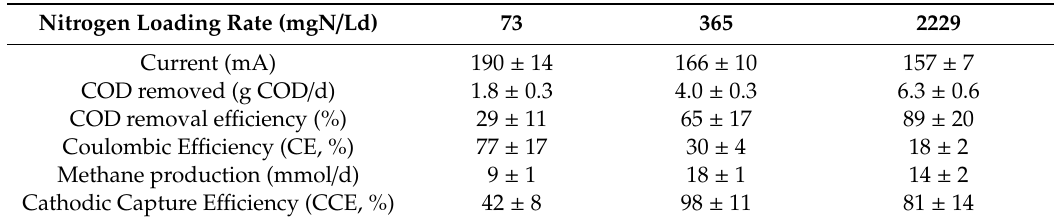
Table 1. Main bioelectrochemical parameters obtained during the three di ff erent operating periods.